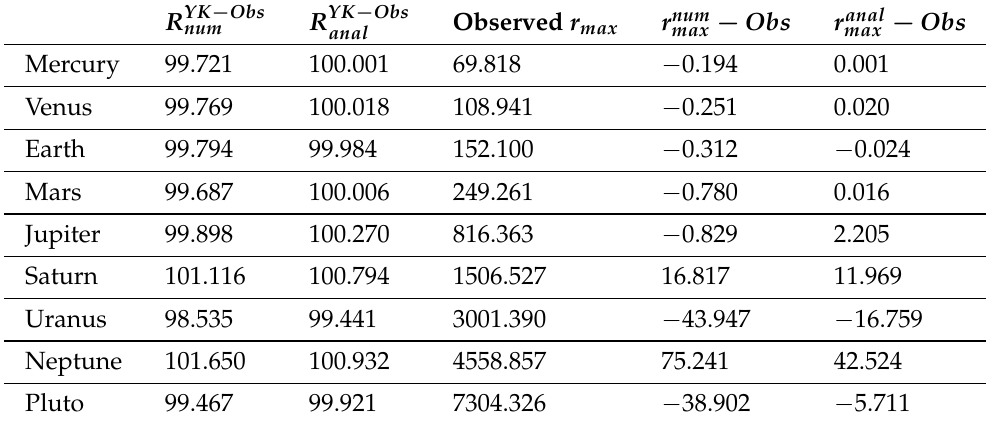
Table A19. Absolute deviation of r max from observation with nominal α , evaluated in (10 6